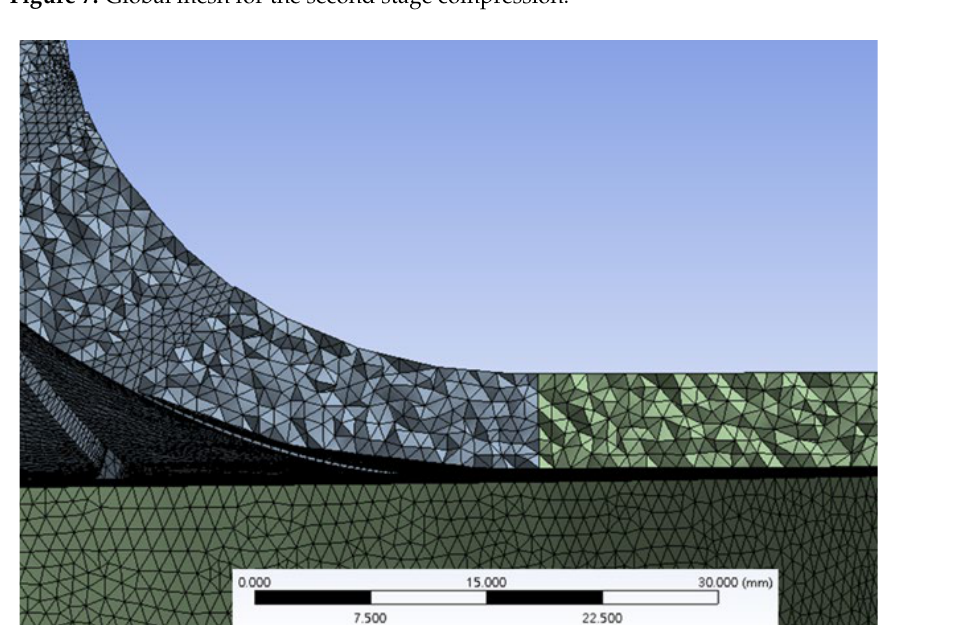
Figure 7. Global mesh for the second stage compression.